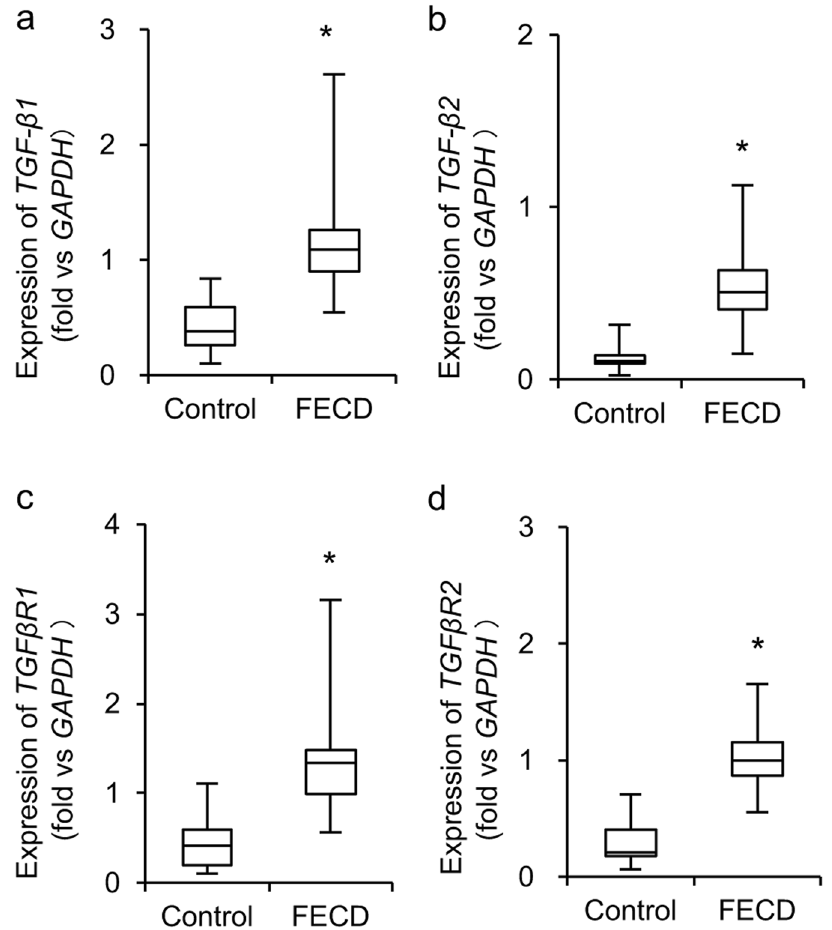
Figure 1. Expression of TGF - β isoforms and receptors in corneal endothelium of patients with FECD. ( a – d ) Descemet’s membranes with CECs were obtained from 30 patients with FECD during Descemet’s membrane endothelial keratoplasty (DMEK). Thirty human donor corneas from non-FECD subject were used as control. Expression levels of TGF - β 1 , TGF - β 2 , TGF β R1 , and TGF β R2 were evaluated by quantitative real-time PCR. GAPDH was used as an internal standard. The horizontal lines in the boxes indicate medians, the bottom of each box indicates the 25th percentile, and the top of each box indicates the 75th percentile. The horizontal lines outside the boxes indicate the range of mRNA level. The statistical analysis was performed by Mann–Whitney U test. * P <